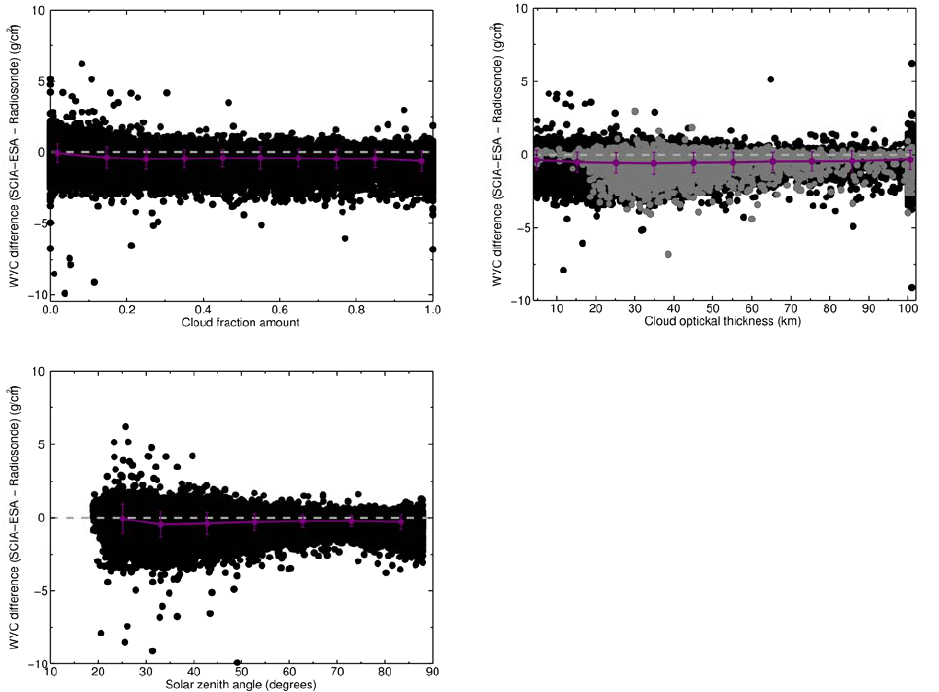
Fig. 4. SCIAMACHY-ESA and radiosonde WVC differences (SCIAMACHY-ESA minus radiosonde amounts) as a function of several parameters. WVC difference as function of cloud fraction amount (top left). Purple points indicate the mean WVC difference for 10 bins. WVC difference as a function of cloud optical thickness (top right). Purple points show the mean WVC difference for 10 bins. Measurement cases where the cloud cover fraction is larger than or equal to 0.9 are indicated in grey. WVC difference as a function of SCIAMACHY solar zenith angle (bottom left). Purple points indicate the mean WVC difference for 7 bins.